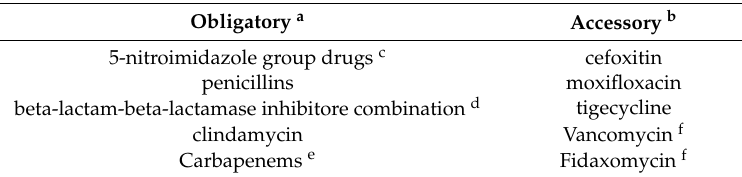
Table 5. Antimicrobial agents that should be included in the routine susceptibility testing on anaerobic isolates